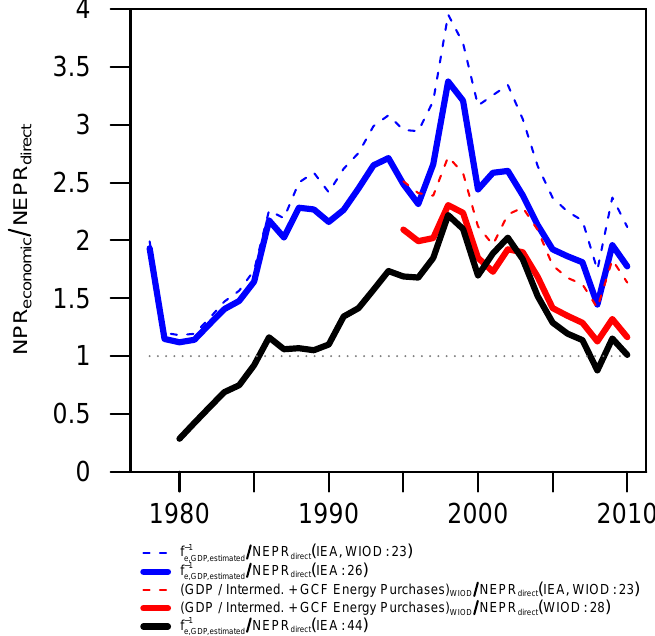
Figure 7. Five calculations of the same ratio show similar trends, but different magnitudes. The plotted lines are the ratio of NPR economic ∼ f − 1 (a monetary-based power return ratio metric) e ,GDP to NEPR direct (a purely energy-based PRR using annual power flows). WIOD: World